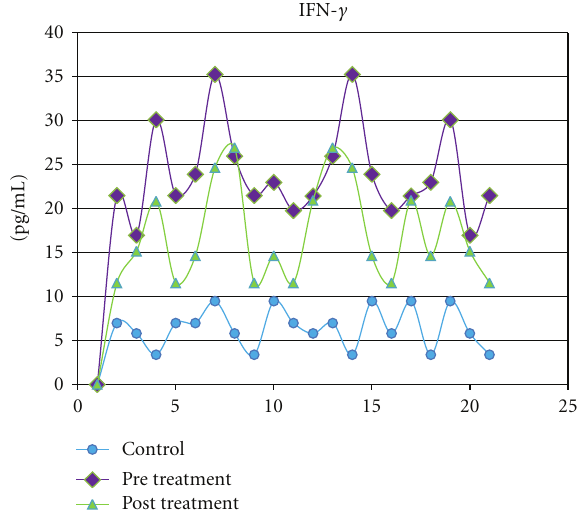
Figure 1: Salivary levels of IFN- γ measured in pg/mL from control subjects compared with levels in ELP patients before and after treatment with prednisone.